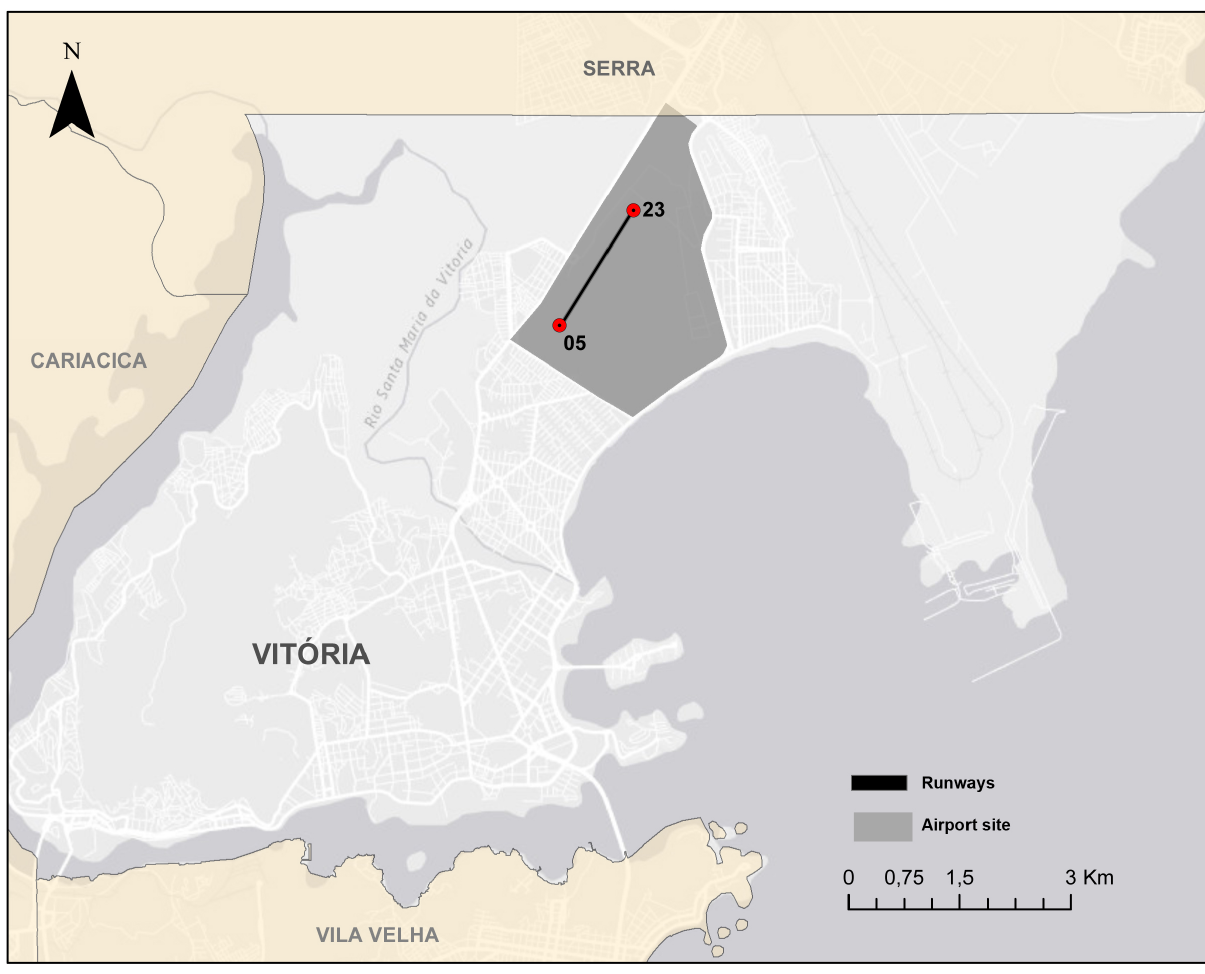
Figure 1: Vitória airport Location map.